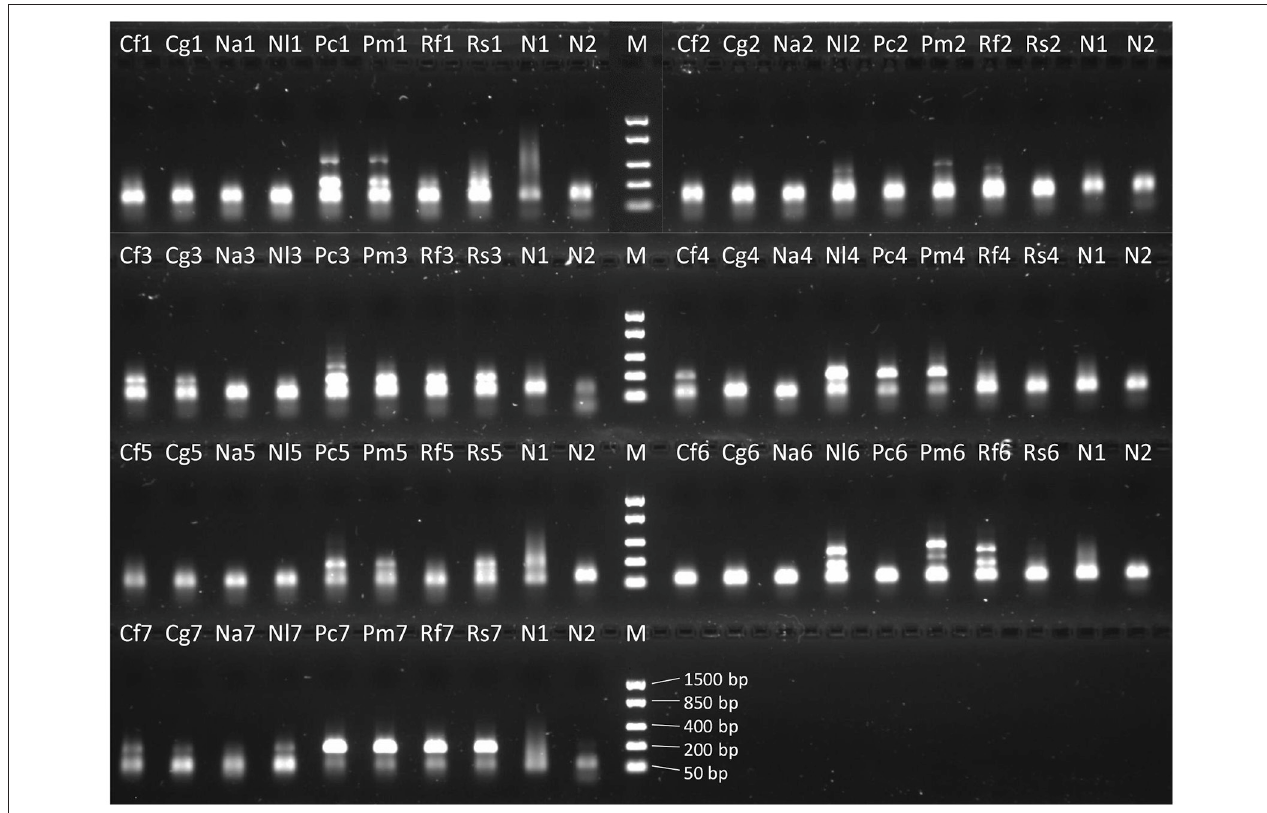
FIGURE 3 | Image of gel visualization of PCR products from the 1985-samples for the seven primer combinations of PCR round 2 ( Figure 2B : 1–7). Cf, Cladonia floerkeana ; Cg, C. gracilis ; Na, Nephroma arcticum ; Nl, N. laevigatum ; Pc, Peltigera collina ; Pm, P. malacea ; Rf, Ramalina fraxinea ; Rs, R. siliquosa ; N1, negative control from PCR round 1 run with PCR round 2; N2, negative control from PCR round 2; M,